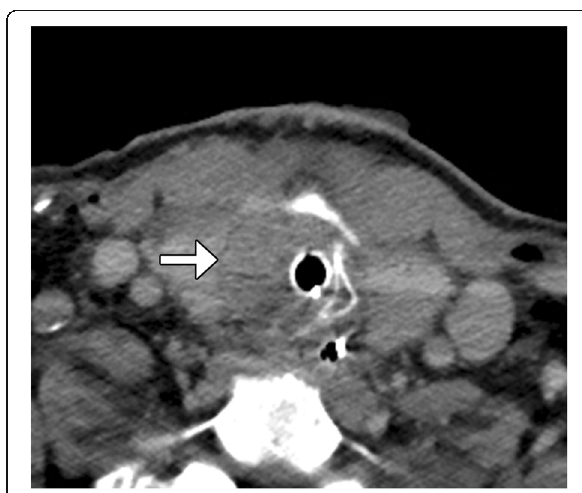
Fig. 4. NUT carcinoma. Axial CT image shows an infiltrative mass in the right visceral space with involvement of the thyroid gland and necrotic right neck lymphadenopathy